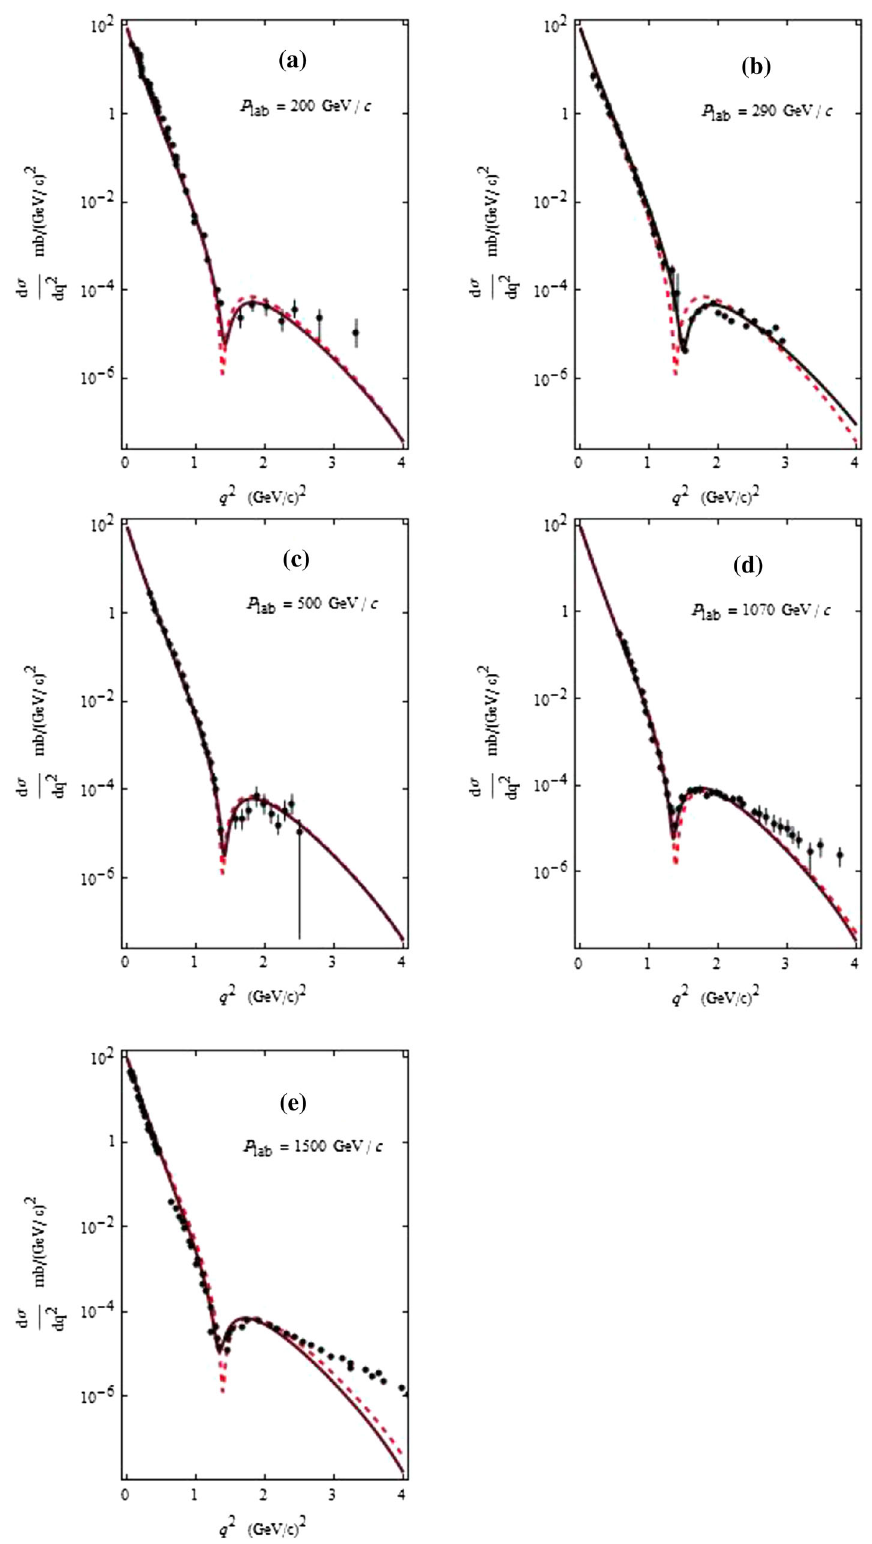
Fig. 2 Same as Fig. 1. The solid and dashed curves represent the results of (two-+ three-quark forces+ pion-cloud) effects of the Fig. 1 and the results of the average values of the parameters in Table 1,